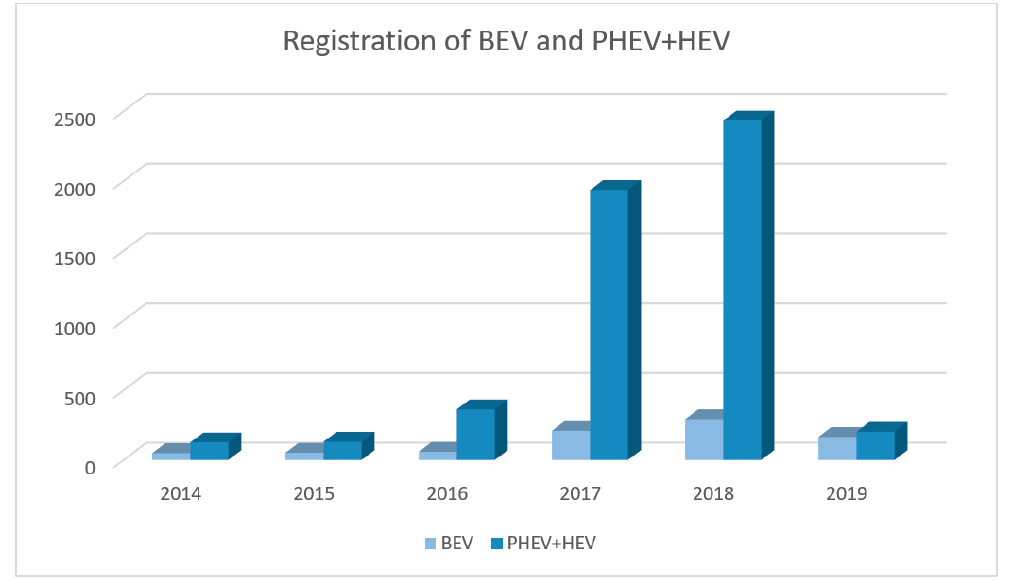
Figure 2. Registration of battery electric vehicle (BEV) and plug-in hybrid vehicles (PHEV) + hybrid electric vehicle (HEV) in 2014–2019 [6].